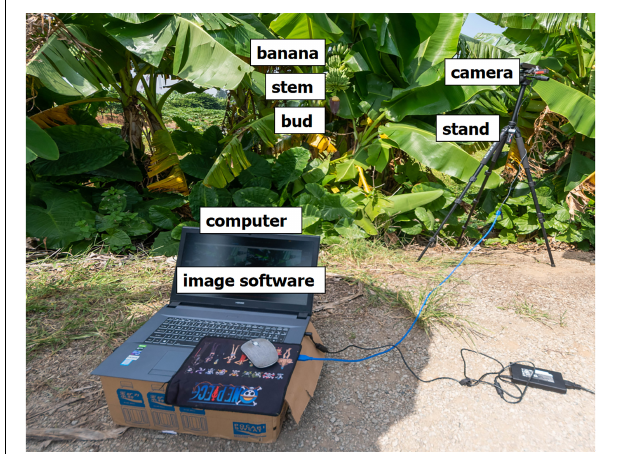
FIGURE 1 | Computer, software, and